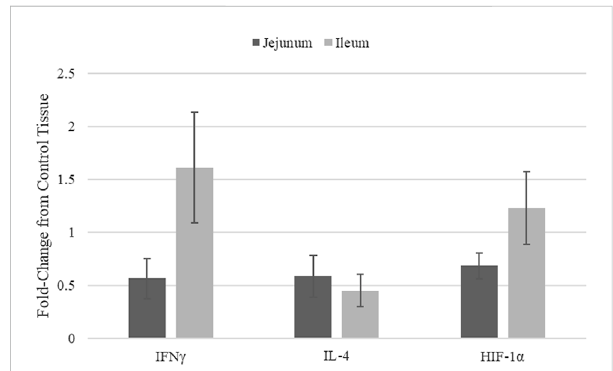
FIGURE 3 mRNA Expression in jejunum and ileum samples from blend-fed chickens compared to those on control